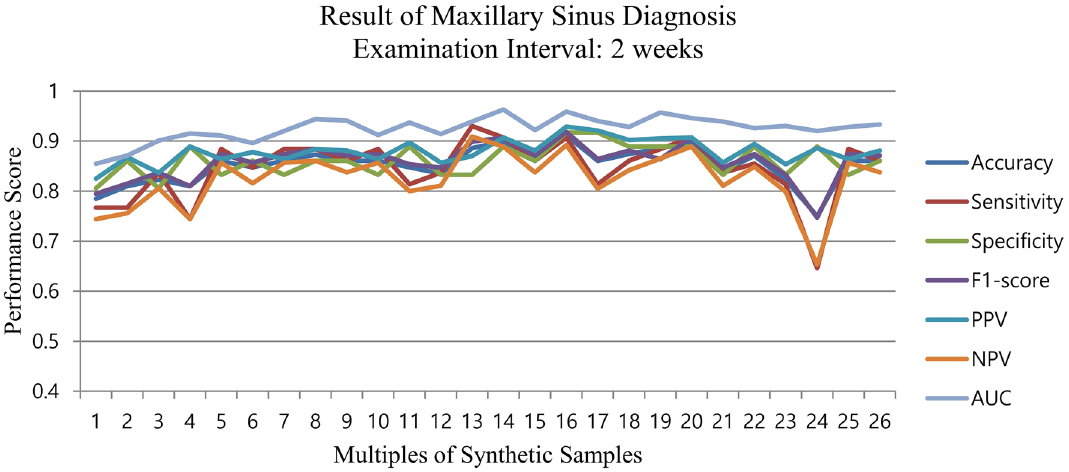
Figure 1. CheXNet performance with an increase in the synthetic training sample